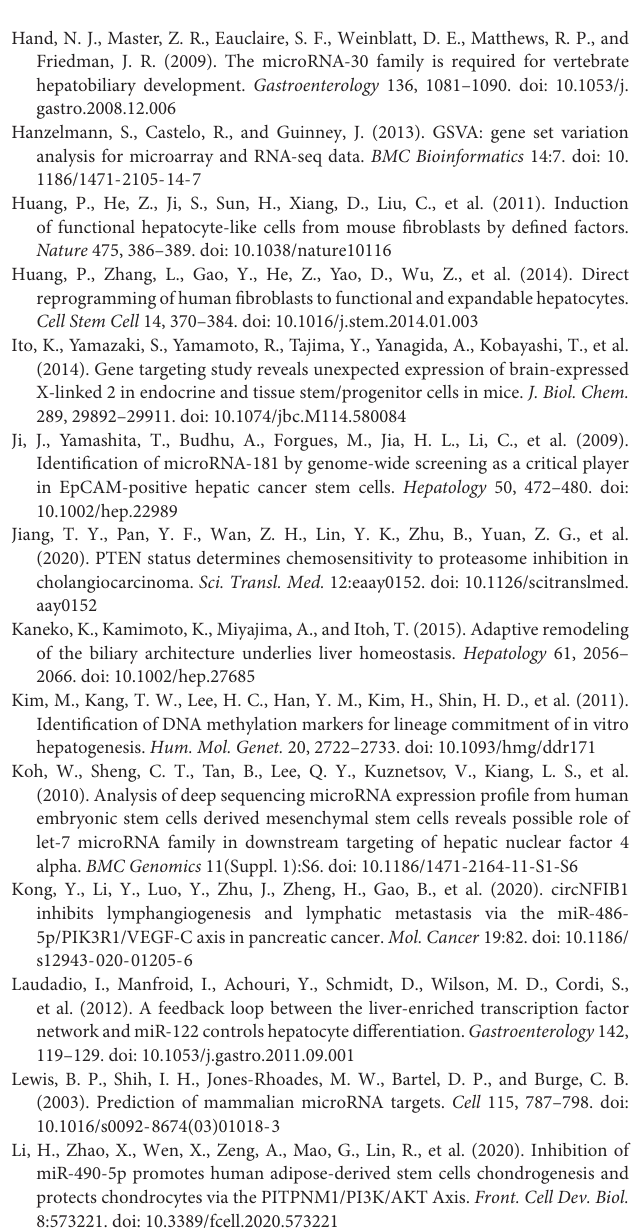
according to GSE73114. (B) Venn plot showing the overlapped miRNA terms between GSE73114 and GSE90047. (C) Heatmap of all GSVA-enriched miRNA terms according to the bulk RNA-seq data from GSE90047. (D) The GSVA score level of 17 miRNAs along hepatic maturation. Supplementary Figure 4 | The characteristics of 23-gene signature in single cell levels. (A) Correlation analysis of 23-gene signature based on 251 cells. (B) Stemness features along hepatoblast-to-hepatocyte differentiation. (C) Expression pattern of five genes along the embryonic trajectory. (D) Correlation analysis of 23-gene signature based on 7,459 hepLPCs. Supplementary Figure 5 | Differential expression analysis of eight miRNAs based on HCC patients in TCGA. Supplementary Figure 6 | Survival analysis of 12 miRNAs based on HCC patients in